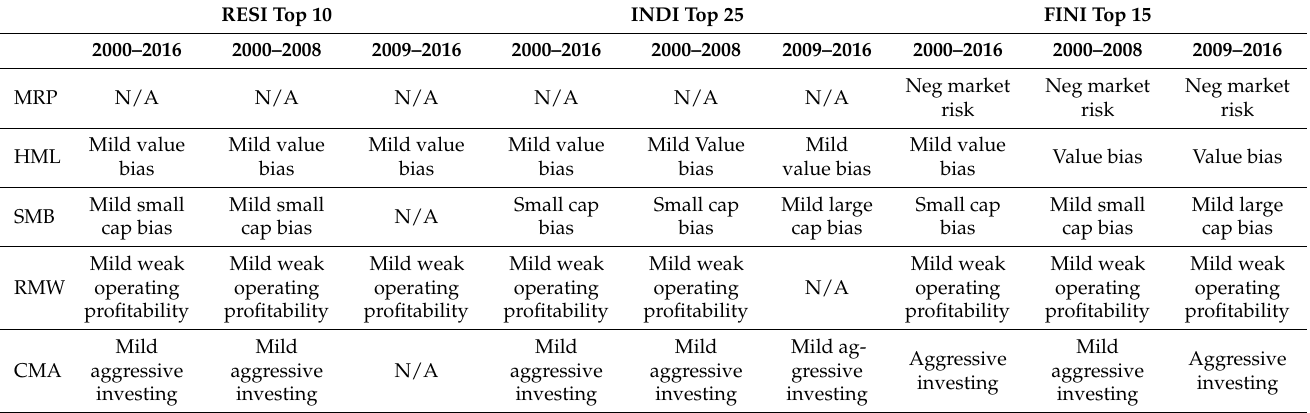
Table 10. Summary of market anomalies present in the five-factor